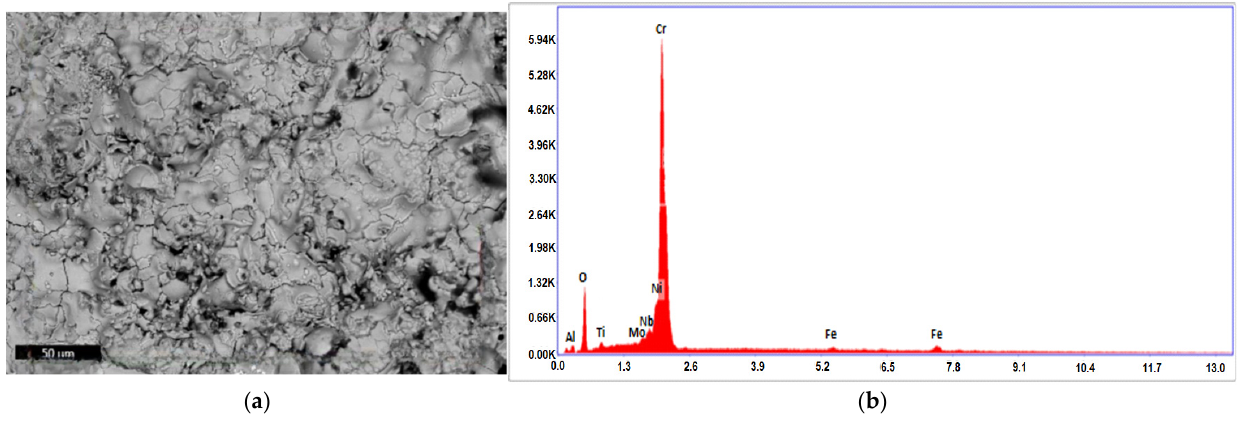
Figure 3. Coated EN8 ( a ) SEM morphology and ( b ) EDS spectrum for isothermal oxidation after 12 h at 900 °C.